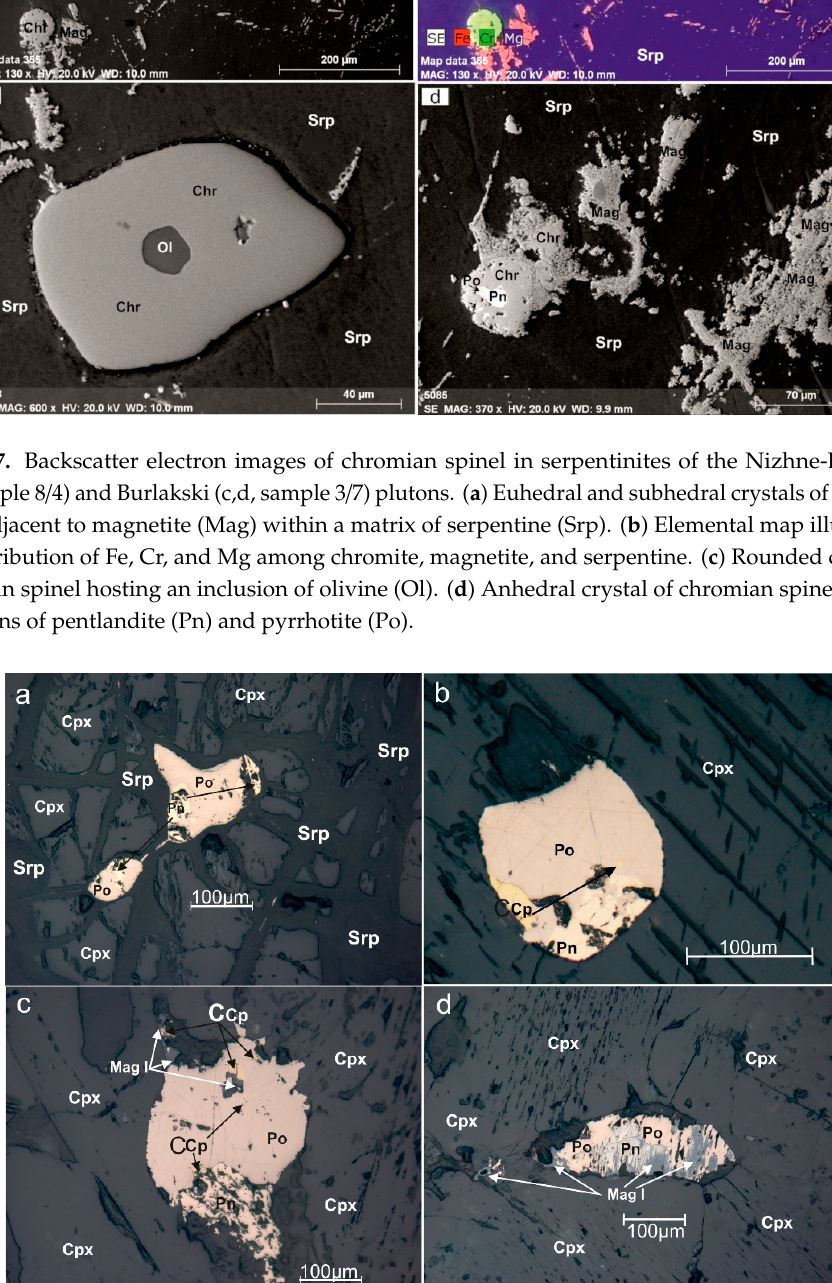
Figure 8. ( a ) An assemblage of pentlandite (Pn) and pyrrhotite (Po) in wehrlite (sample 3/1, Burlakski pluton). ( b , c , d ) An assemblage of chalcopyrite (Ccp)-pentlandite (Pn) and pyrrhotite (Po) in clinopyroxenite (sample 3/6, Burlakski pluton). Cpx, clinopyroxene; Srp, serpentine; Mag I, first generation magnetite.